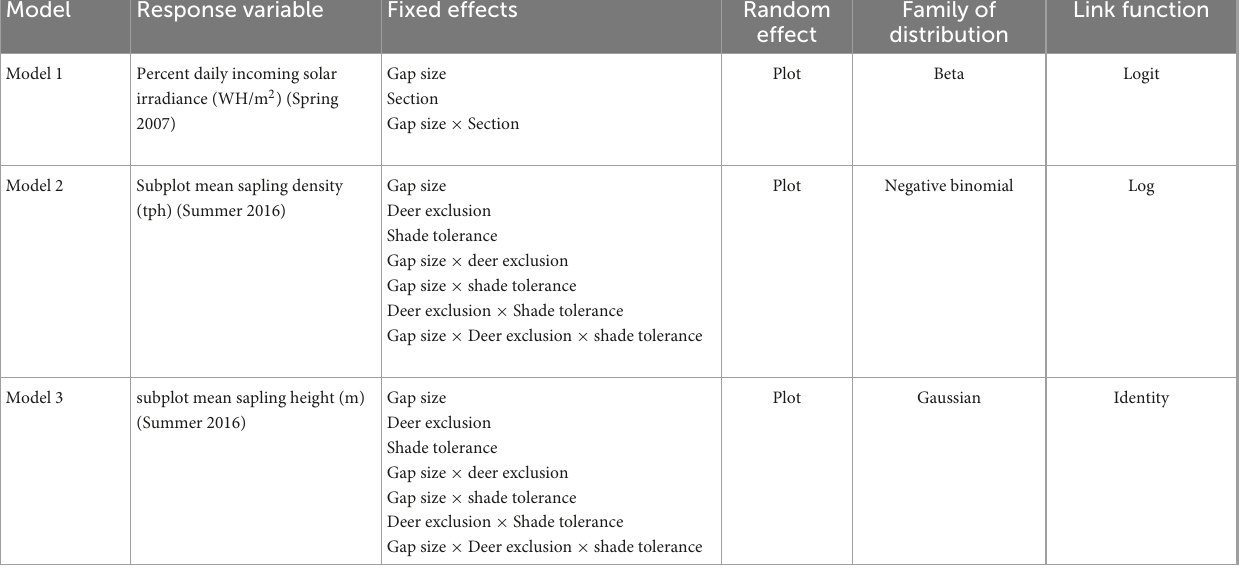
TABLE 2 Response variables, fixed effects, random effects, distribution families, and link functions used to analyze three proposed models of factors effecting light and sapling dynamics. Model